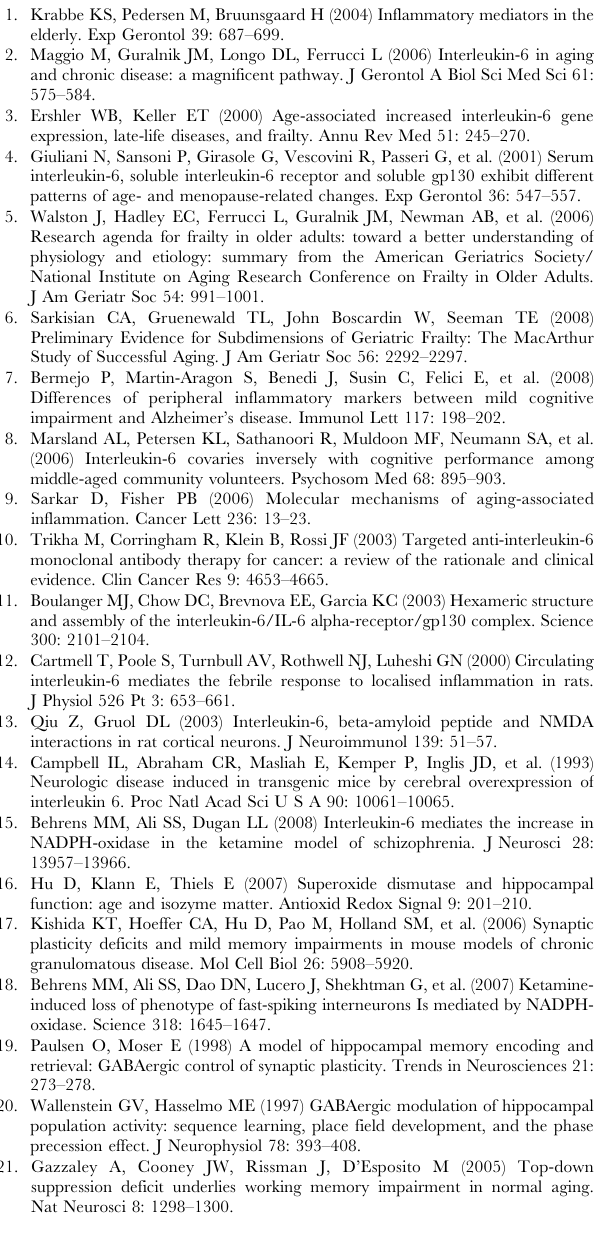
before the groups were sacrificed 12 hrs later for synaptosomal isolation.